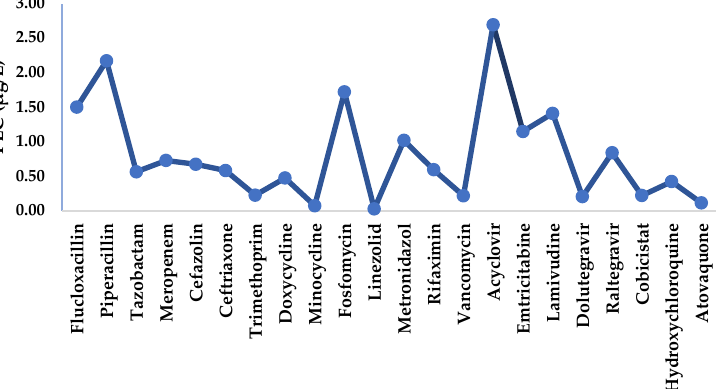
Figure 4. Predicted environmental concentration (exposure) of surface water to selected active substances.